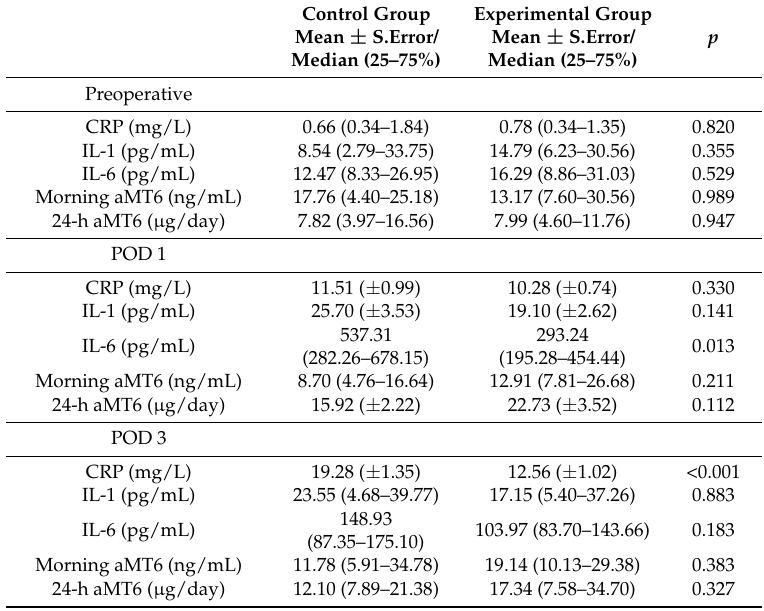
Table 2. Preoperative and postoperative plasma CRP, IL-1, IL-6, and urine aMT6